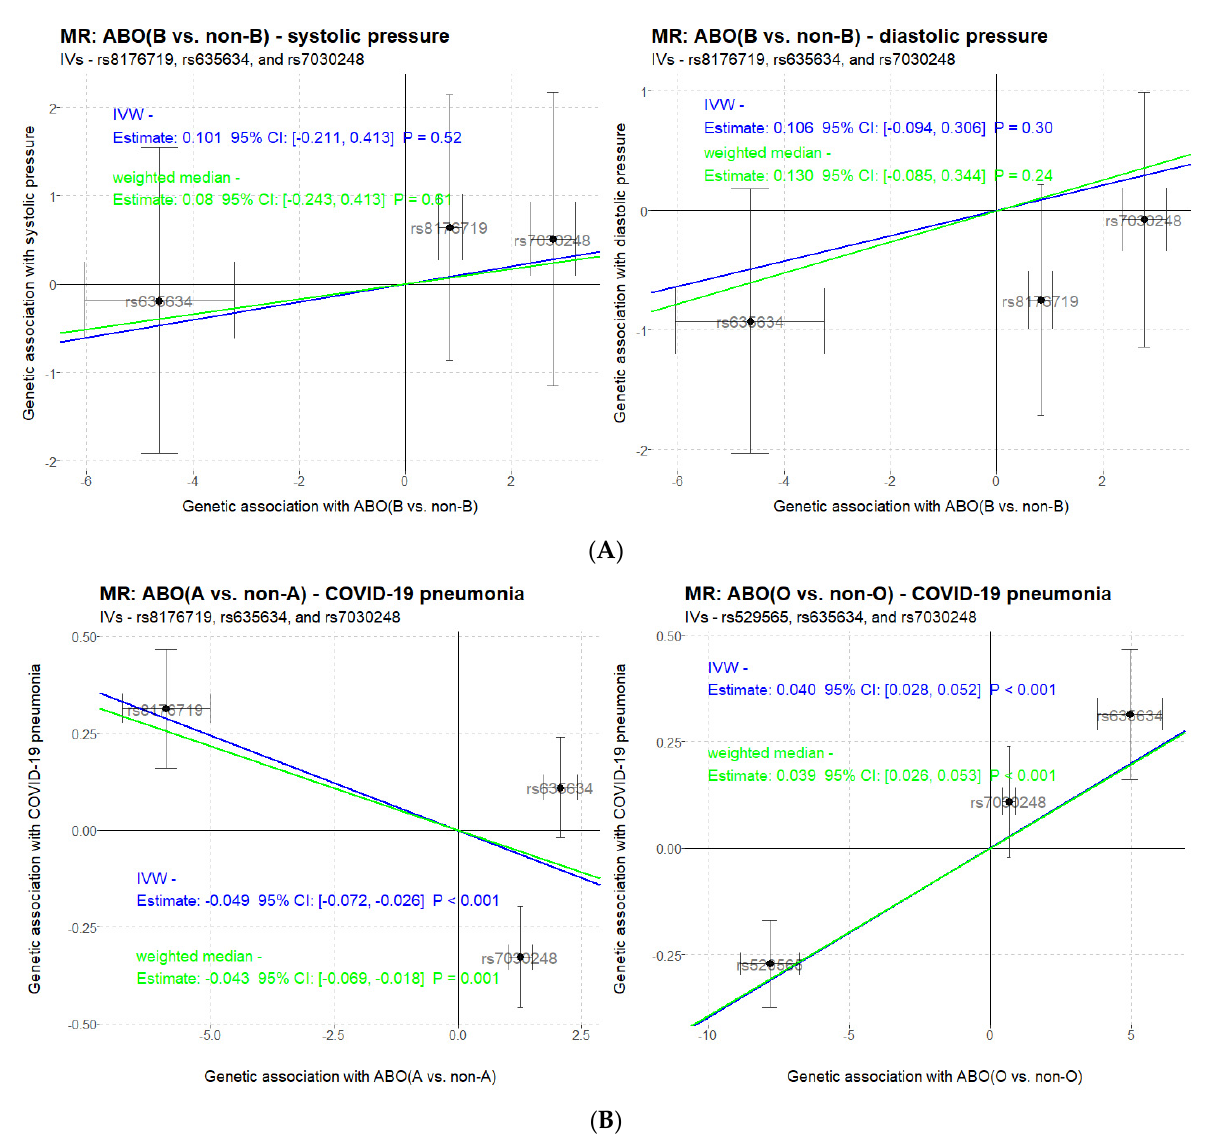
Figure 5. Mendelian randomization analysis between ABO blood types (exposure) and phenotypes-of-interest (outcome). ( A ) One-sample MR of ABO-blood pressures; ( B ) two-sample MR of ABO-severe COVID-19 with respiratory failure.